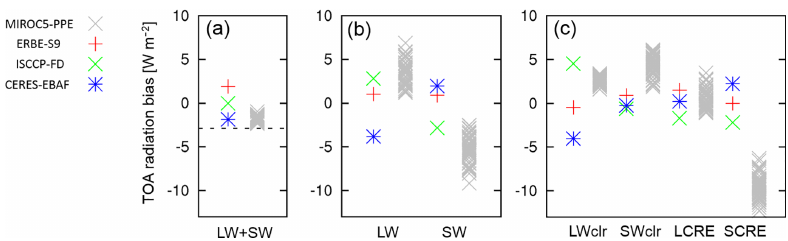
Figure 1. TOA radiation bias in the global annual mean for (a) net, (b) longwave and shortwave, (c) longwave clear-sky, shortwave clear-sky, longwave CRE, and shortwave CRE components. The biases are with respect to the average of three observational data, namely, ERBE-S9, ISCCP-FD, and CERES-EBAF. The net radiation of zero with no TOA imbalance is indicated by the dashed line in (a) . The unit is Wm − 2 and the signs are positive downward.